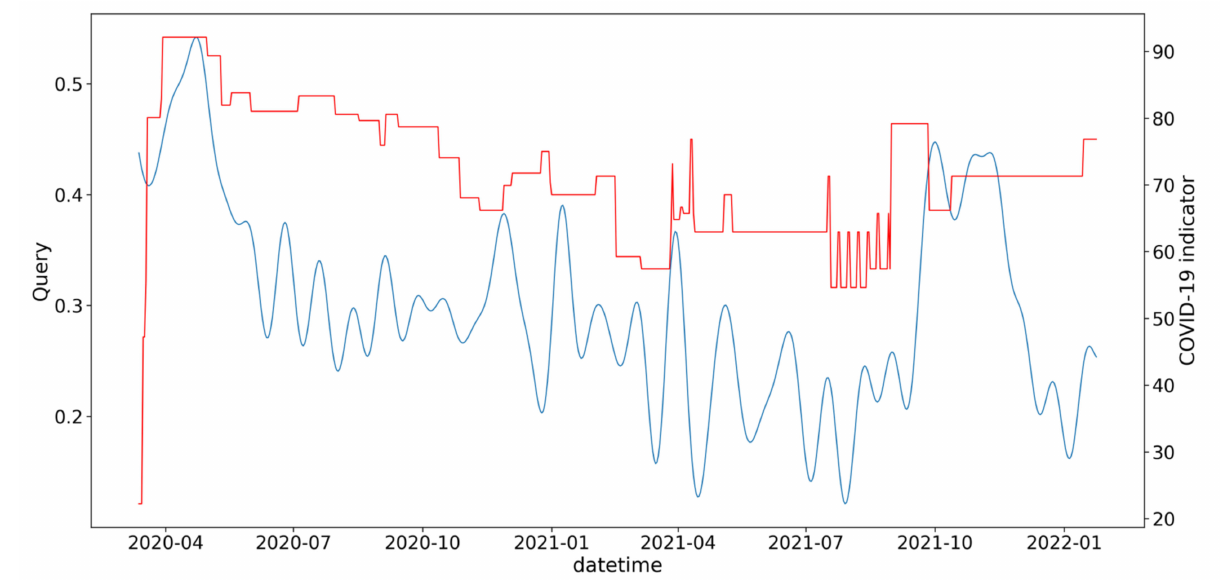
Figure 9. The red line represents the Stringency index, and the blue line represents the dynamics of the publication activity on topic “crisis, credit, debt,